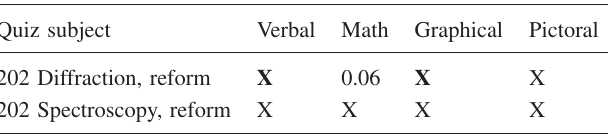
TABLE IV. Statistical significance of the quiz performance dif- ferences between the format choice and control groups in the re- formed 202 section. Numbers are p values using a two-tailed bino- mial proportion test. X denotes a p value of greater than 0.10. Bold indicates that the choice group had higher performance than the control group. Quiz subject Verbal Math Graphical